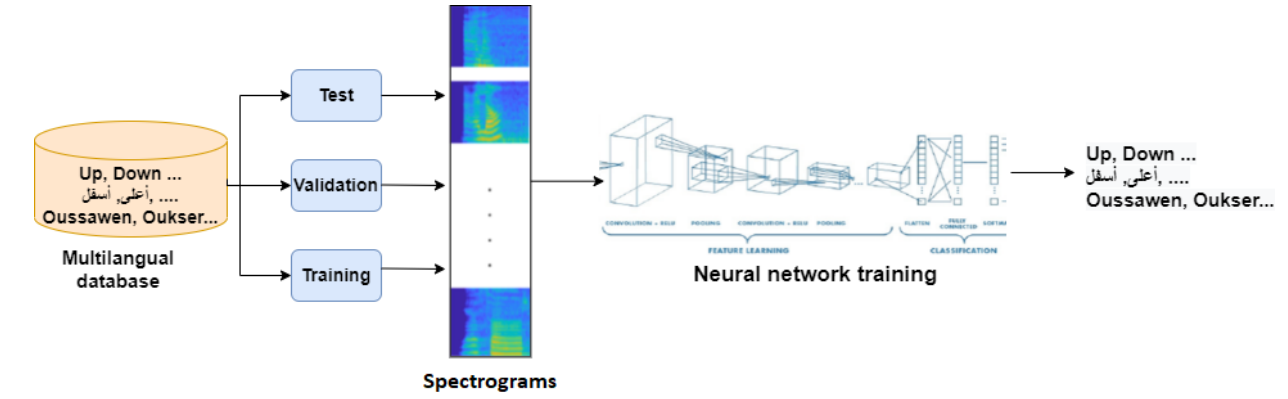
Figure 4. Deep Learning Model for